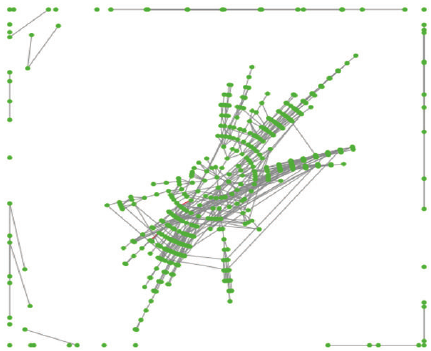
Figure1:Samplenetworkgeneratedbythisdynamicfriendnetwork model, where 𝑁 = 500 , 𝛼 = 5 , 𝛽 = 10 , 𝑚 = 5 , 𝜅 = 0.00005 , 𝑝 1 = 1 , and 𝜆 = 0.3